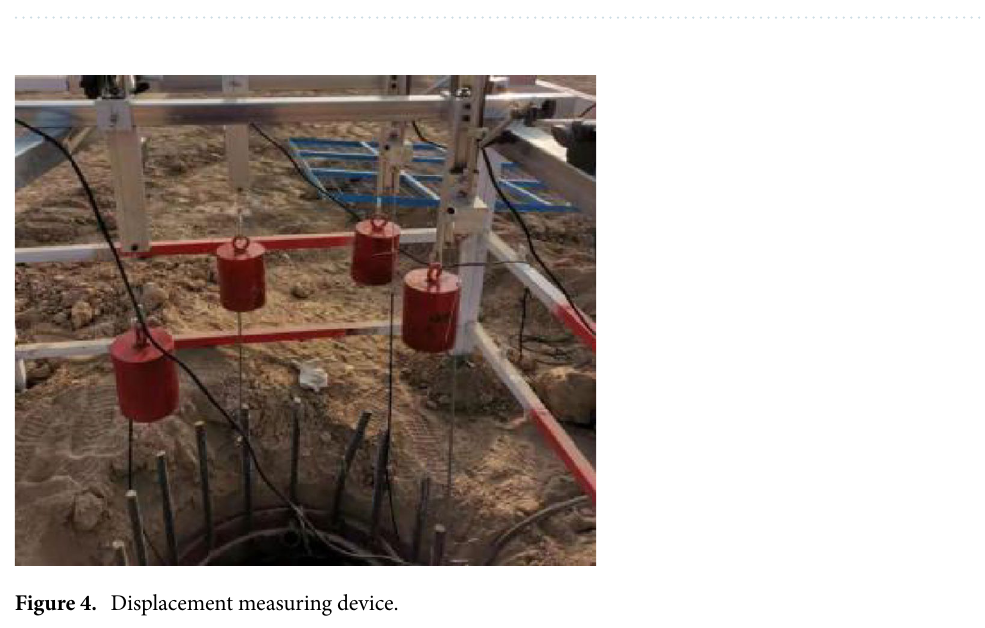
Figure 3. Load box.